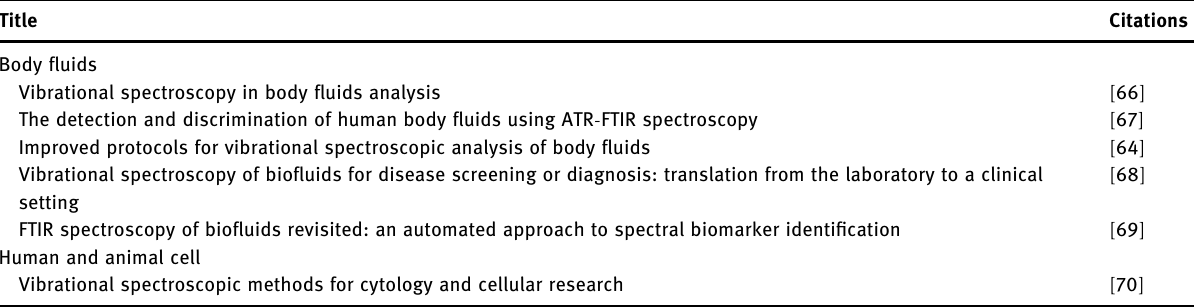
Table 4: Selected publications on using FTIR spectroscopy for bio fl uid analysis